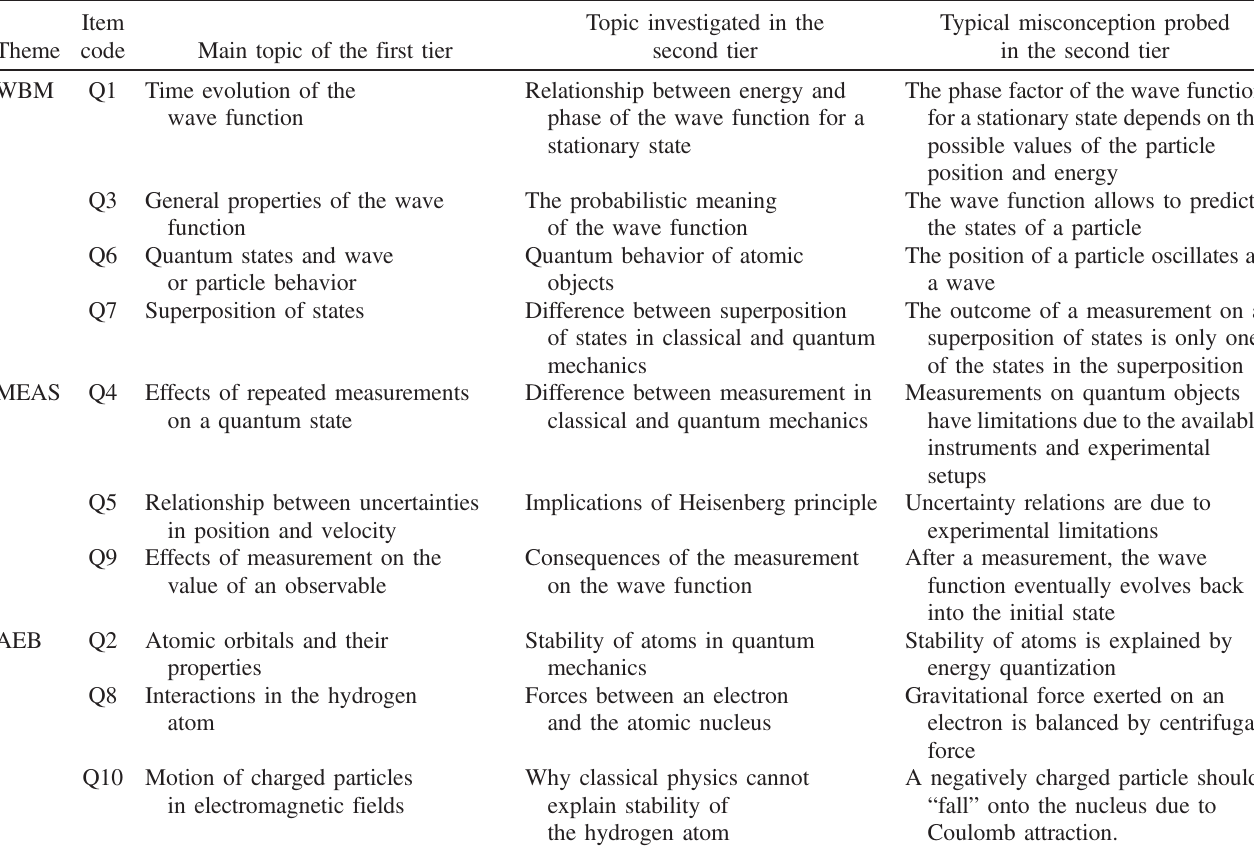
TABLE I. Overview of the QME contents. The complete questionnaire is reported in the Appendix. Theme